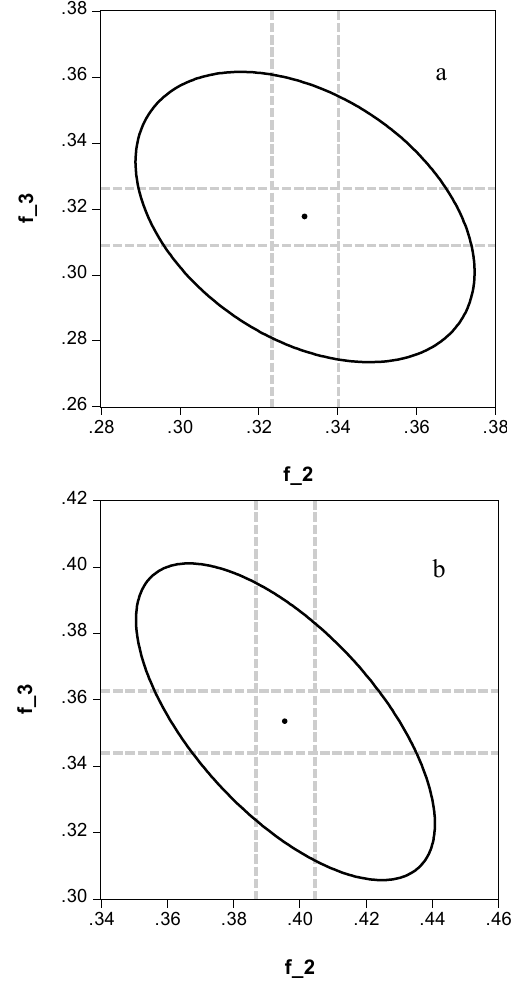
Fig. 4. 95% confidence region of φ 1 and φ 2 parameters for (a) θ and (b) h serie.